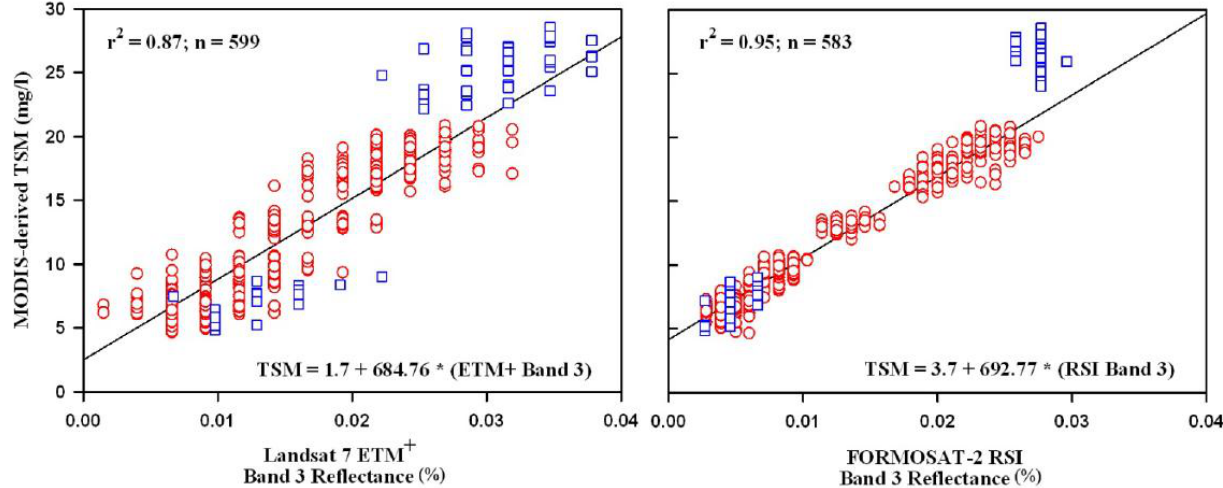
Figure 4. Relationship between TSM concentrations derived from MODIS 250 band 1 normalized water-leaving radiance and Landsat 7 ETM+ (left panel) and FORMOSAT-2 RSI (right panel) atmospherically corrected band 3 reflectance. Solid line is the least- squares fit to the data. Matchups correspond to 8 November 2010 (red circles) and 10 December 2010 (blue squares) images.